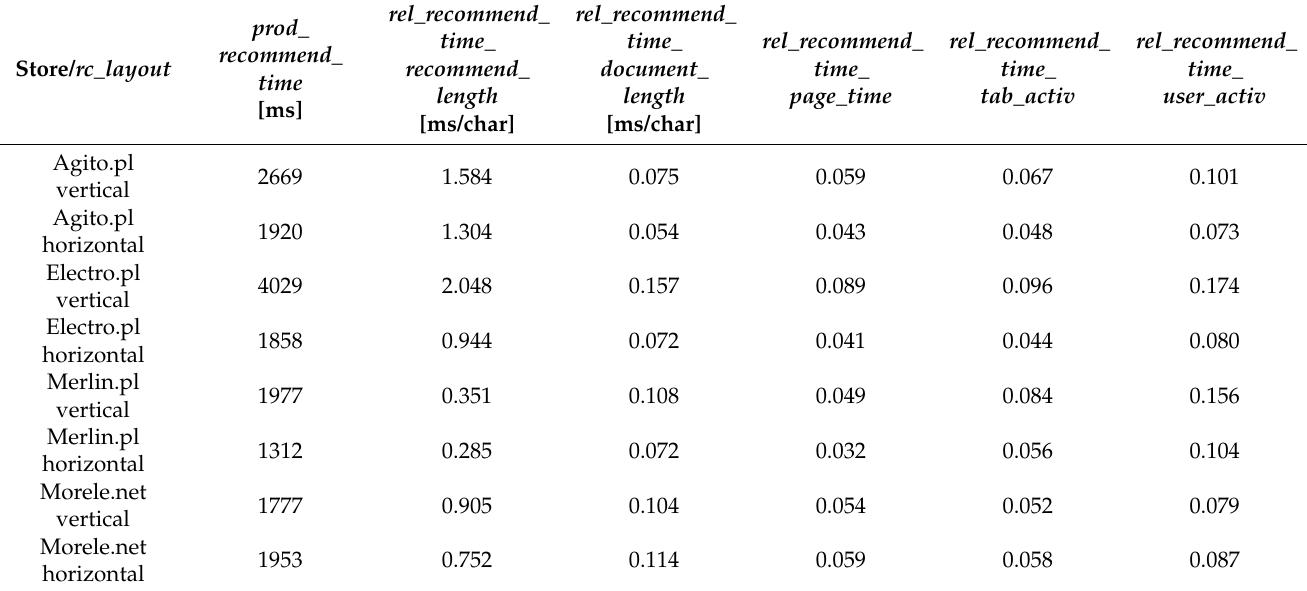
Table 19. Recommending interface quality parameters based on the ECPM study.